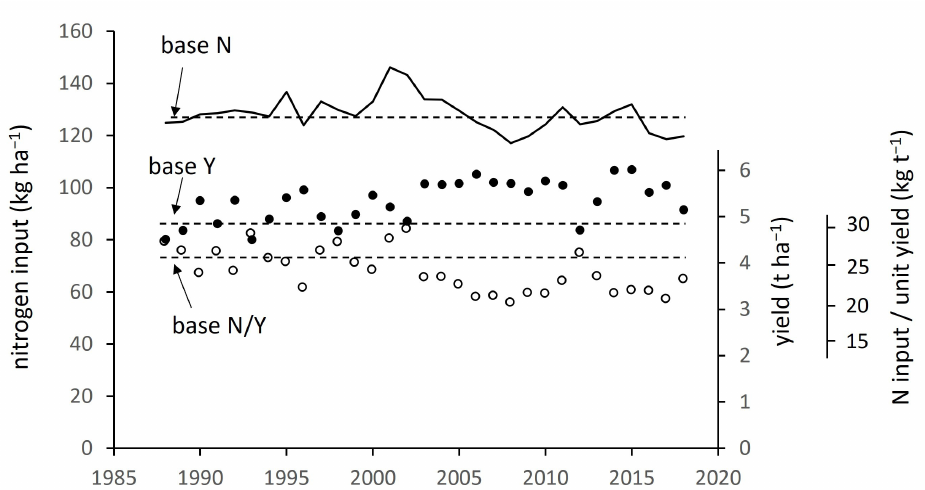
Figure 2. Trends for all cereals in nitrogen fertiliser input (N, line), grain yield (Y, closed circles) and N per unit yield (N/Y, open circles), horizontal dashed lines showing the respective base values around the year